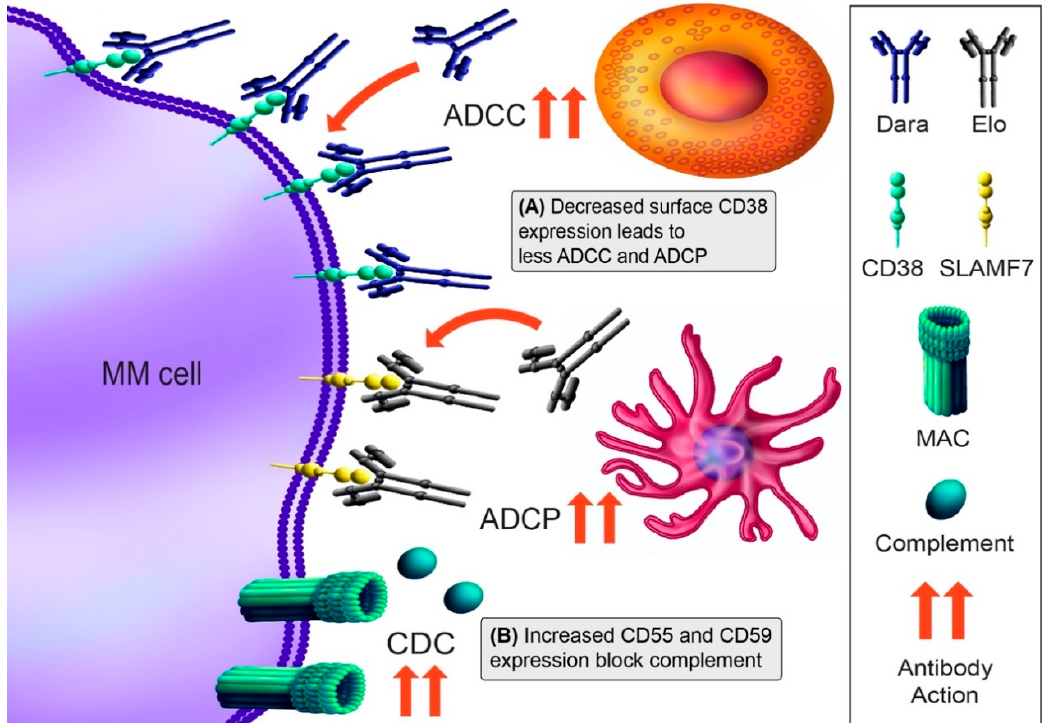
Figure 3. Immunotherapy mechanisms of action and resistance mechanism. The monoclonal antibody (mAb) daratumumab (Dara) binds to CD38 and induces cytotoxicity through antibody-dependent cellular cytotoxicity (ADCC; NK cell [orange], macrophage [pink]), complement-dependent cytotoxicity (CDC; membrane attack complex [MAC]), antibody-dependent cellular phagocytosis (ADCP; macrophage), and direct blocking of CD38 function. Elotuzumab (Elo) recognizes SLAMF7 and results in direct activation of NK cells and ADCC. ( A ) Downregulation of CD38 mediates Dara resistance, in part by trogocytosis of CD38 from MM cells. ( B ) A second mechanism of Dara resistance may be the upregulation of complement-inhibitory proteins CD55 and CD59. Antibody action is denoted by red arrows. The mechanisms shown are for Dara resistance mechanisms, as no Elo resistance mechanisms have been described.